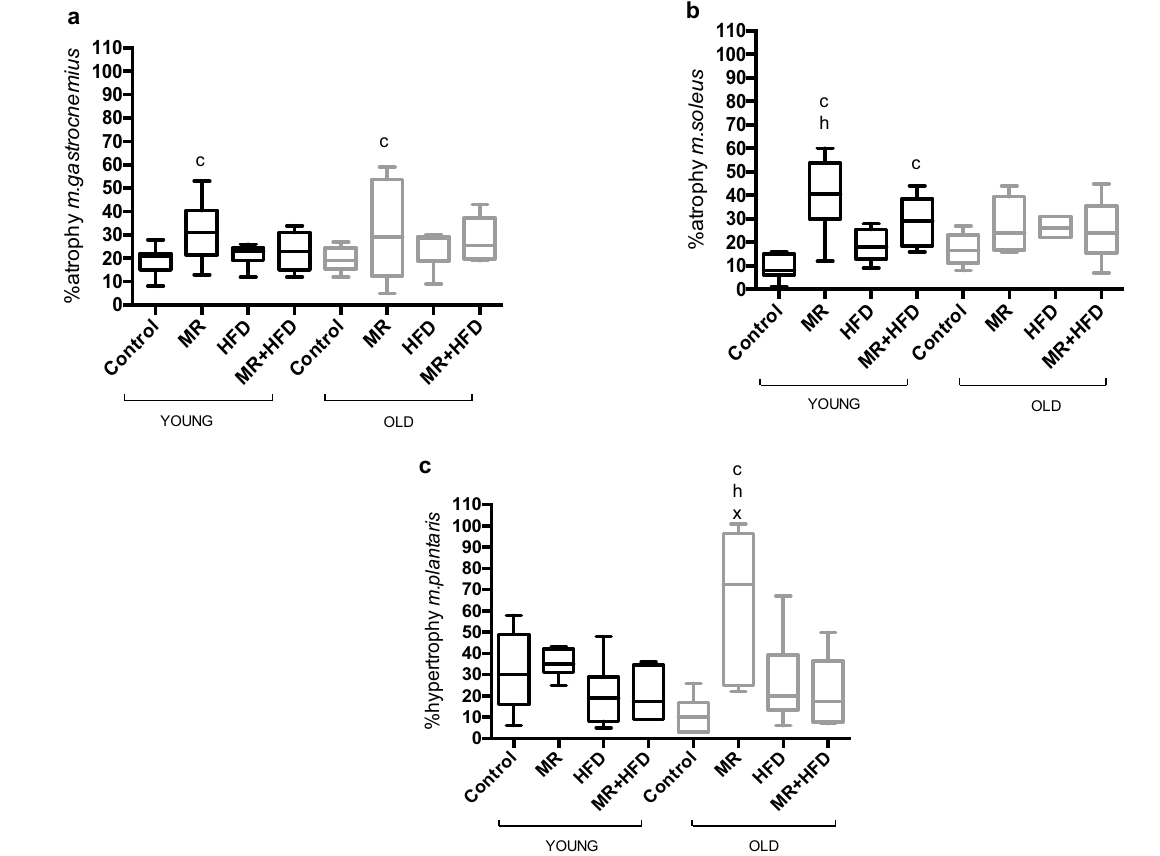
Figure 4. ( a ) % atrophy m. gastrocnemius, ( b ) % atrophy m. soleus and ( c ) % hypertrophy m. plantaris of young (black boxes) and old (grey boxes) mice fed—control, methionine restricted (MR), high fat diet (HFD) and MR + HFD. c, h, x: significantly different from control, HFD and MR + HFD respectively at p ≤ 0.027. Data is presented as mean, min,